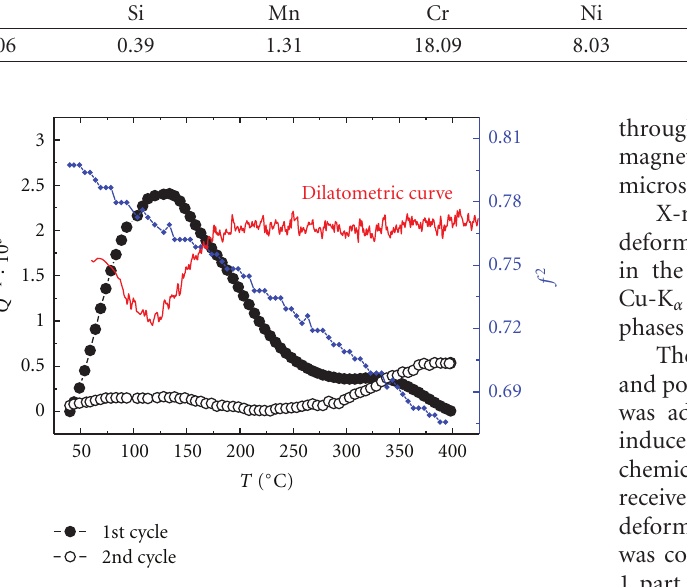
Figure 3: Internal friction spectra of sample with previous true deformation of 0.06 by tensile test at − 50 ◦ C during the first heating (in black) and the second heating cycle (hollow) in the same sample. The respective dilatometric curve from Figure 4(b) was